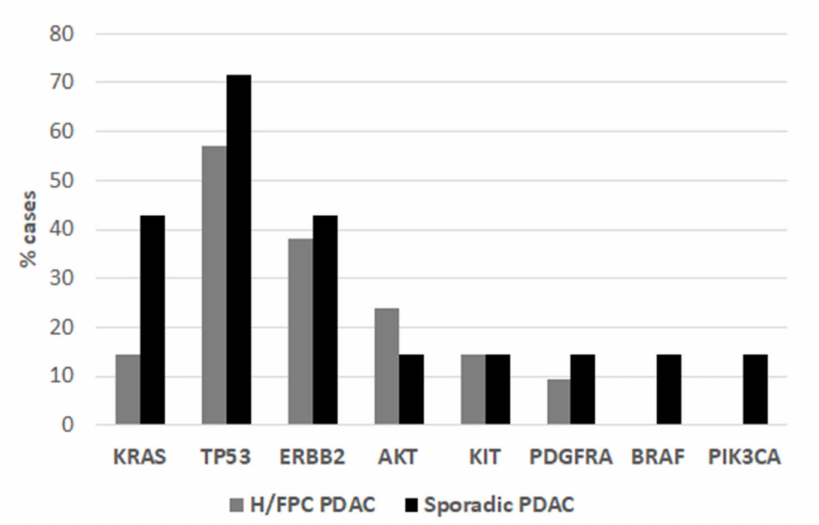
Figure 3. The frequency of somatic mutations in hereditary or familial cases and sporadic was determined by sequencing analysis. Table 2. Summary of the somatic mutations detected in H/FPC and sporadic cases by sequencing analysis. Case Somatic Mutations Detected by Sequencing KRAS Status by BEAMing